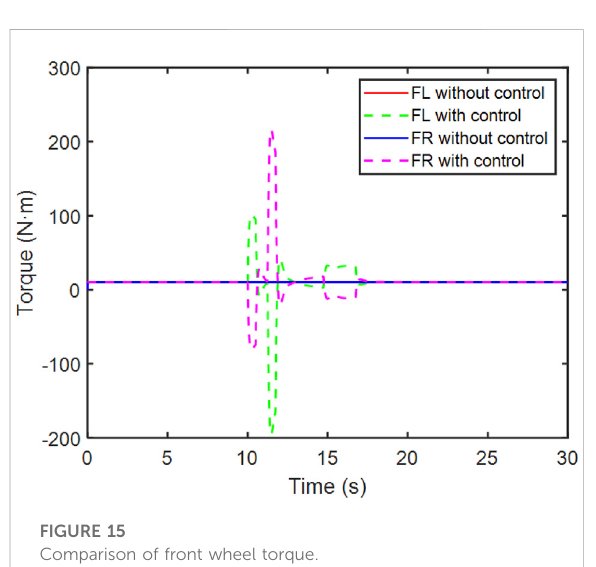
FIGURE 14 Steering angle variation during the fi shhook maneuver.